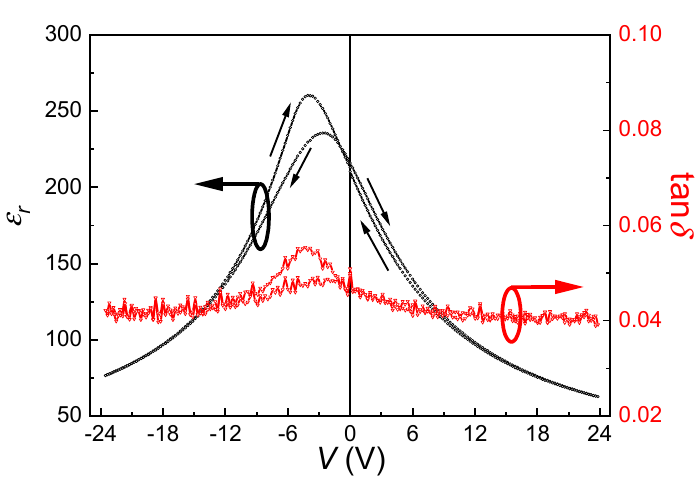
ε Figure 6. Room-temperature 𝜀 (cid:3045) -V curves for the (110)-oriented epitaxial BZT-BCT thin films. Figure 6. Room-temperature r -V curves for the (110)-oriented epitaxial BZT-BCT thin